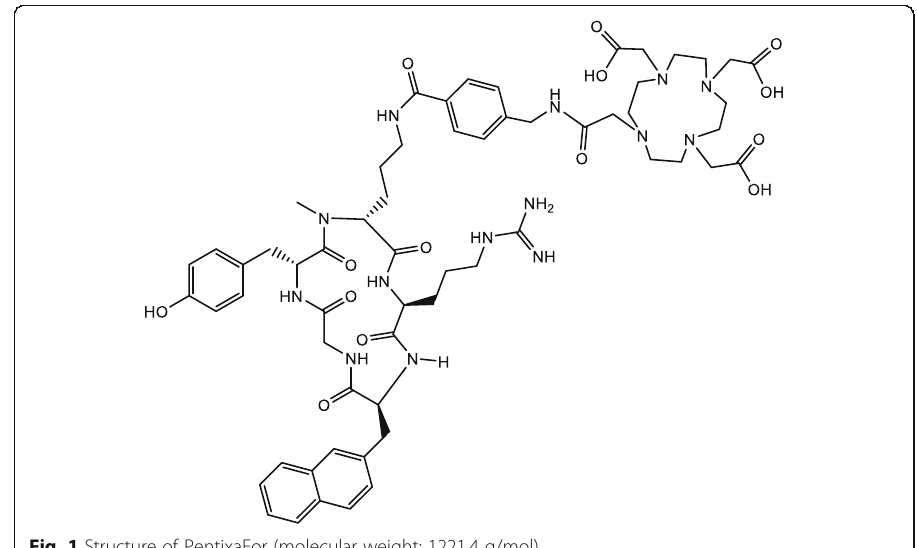
Fig. 1 Structure of PentixaFor (molecular weight: 1221.4 g/mol)